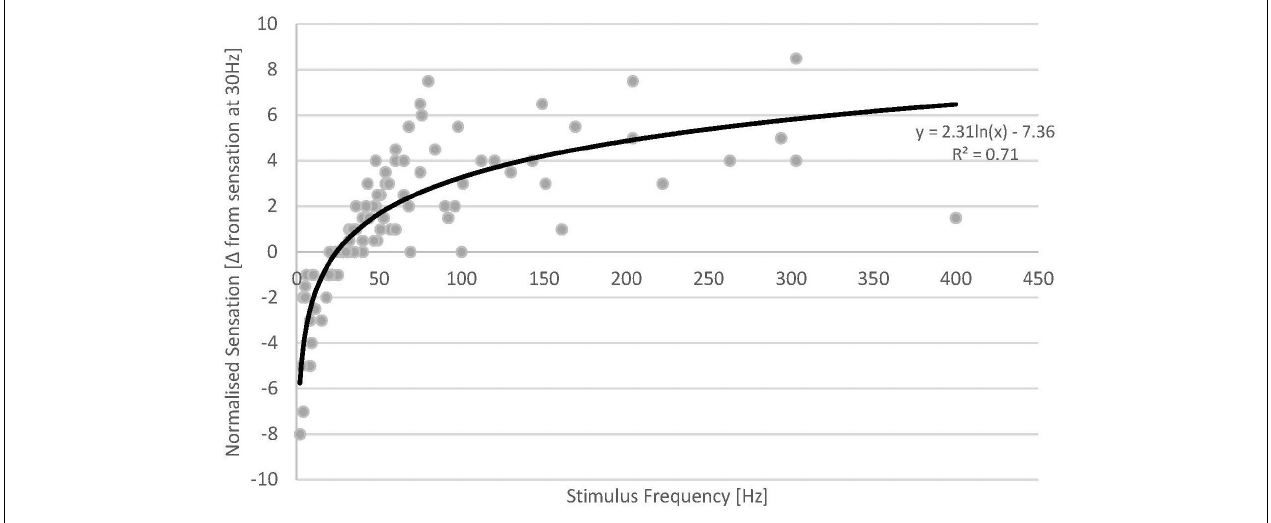
FIGURE 4 | Normalised sensation of all patients versus stimulus frequency (grey dots) (a total of 18 sweeps across 13 patients). Fewer data points are available at high stimulus frequencies as the stimulus sensation often became too strong for the patients at the given stimulus amplitude used. A logarithmic fit was added (solid